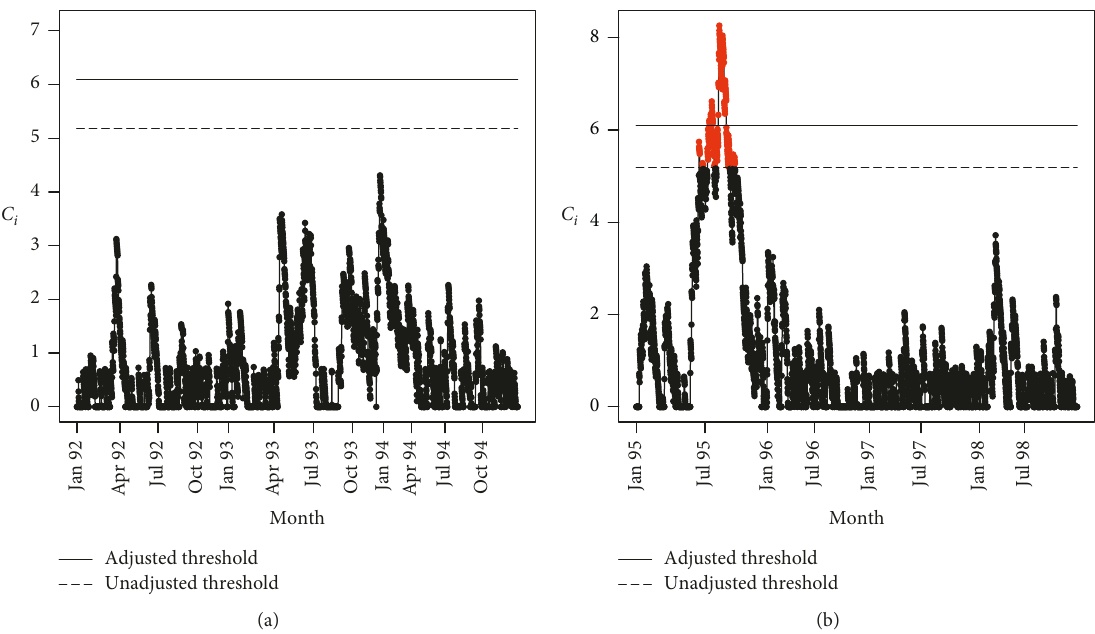
Figure 2: RA-CUSUM chart for Phase-I and Phase-II assuming first three years as the Phase-I for 30 days mortality of cardiac surgery patients. (a) Phase-I chart, unadjusted UCL � 5.184 and adjusted UCL � 6.125. (b) Phase-II chart, unadjusted UCL � 5.184 and adjusted UCL � 6.125.